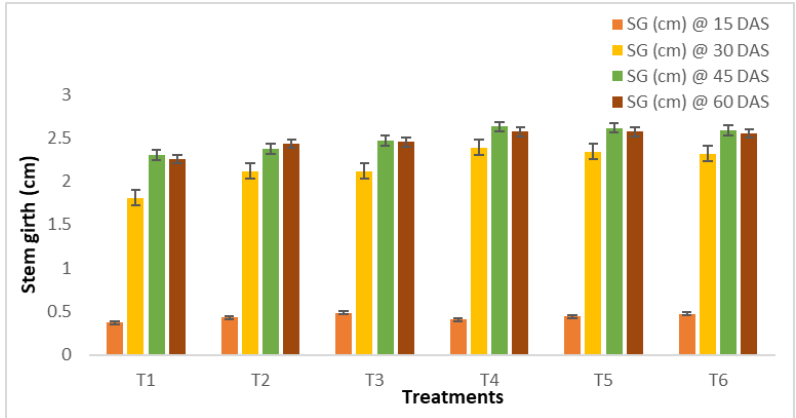
Figure 3. Effects of NPK consortia biofertilizer and chemical fertilizers on mean of stem girth at different growth stages; SG = Stem Girth, DAS = Days after